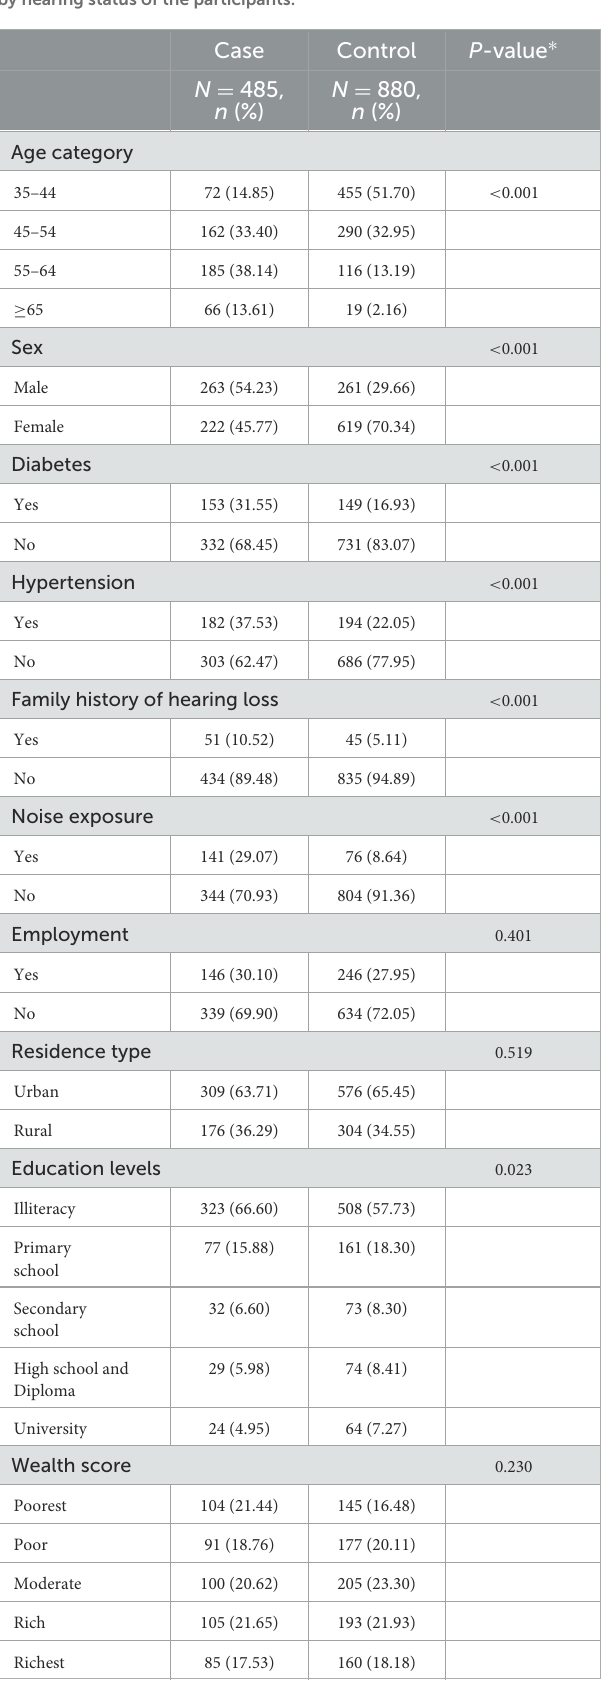
TABLE 1 Demographic, socioeconomic, and comorbidity characteristics by hearing status of the participants.